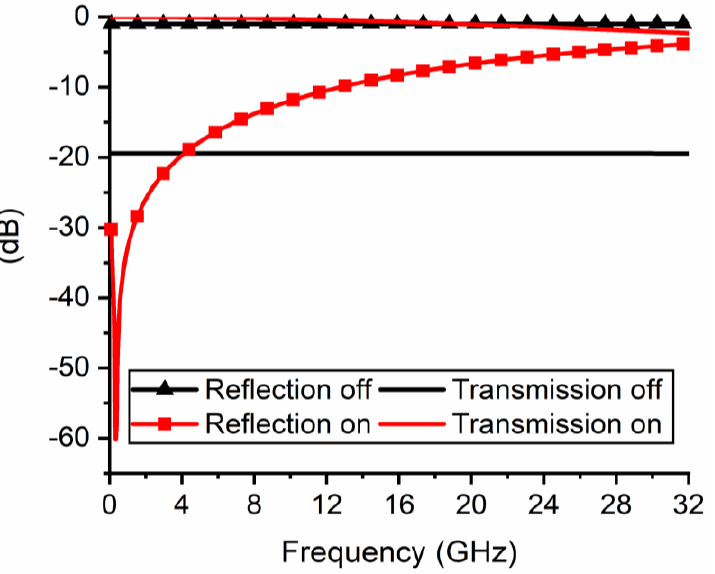
Figure 12. Scattering parameters of the FTJ-based microwave switch in its ON- and OFF-states, in the band 0.1 – 32 GHz.